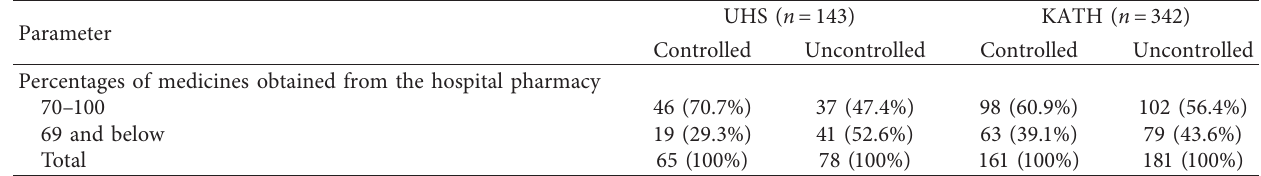
Table 6: Association between access to antihypertensive medications and blood pressure